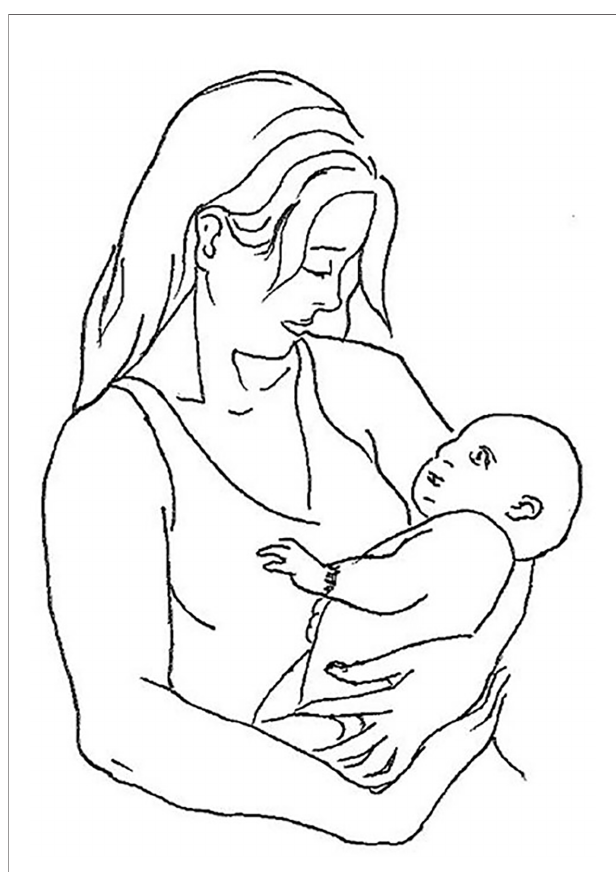
FIGURE 1 | Graphic representation of left-cradling behavior (courtesy of Rocco